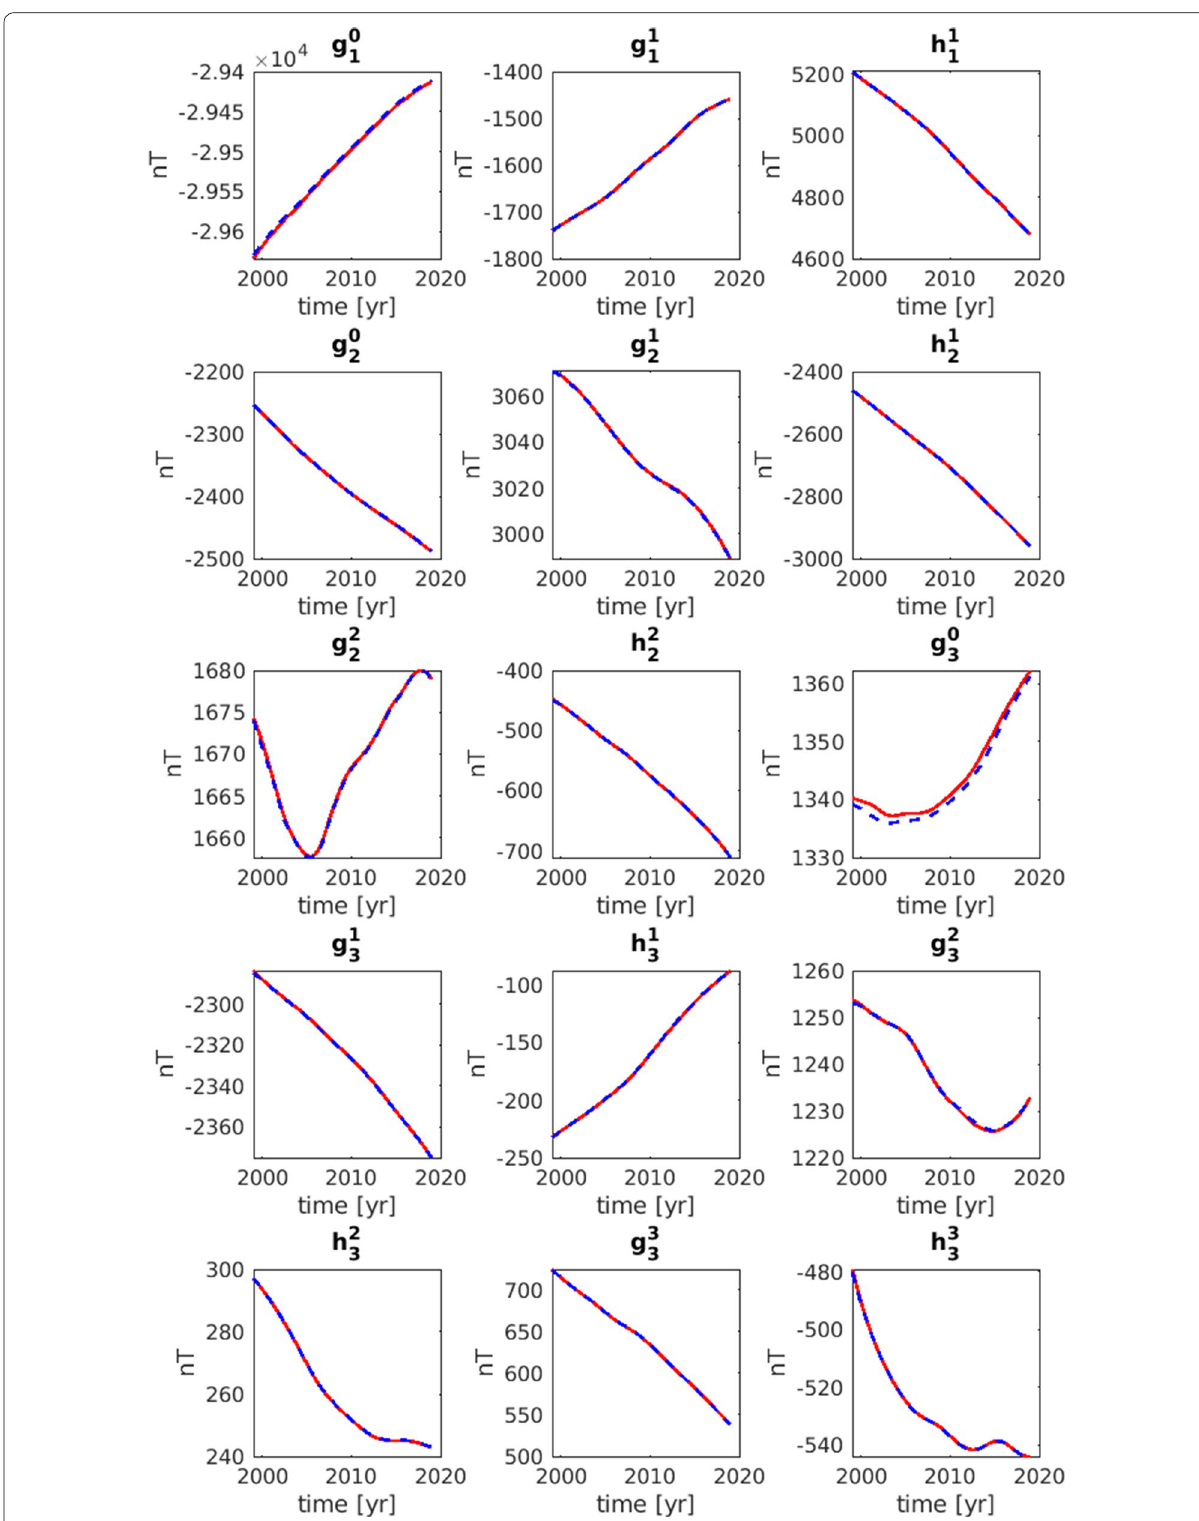
1 3 at radius a 6,371.2 km from CM6 (solid red) and CHAOS (dashed blue) from = − =